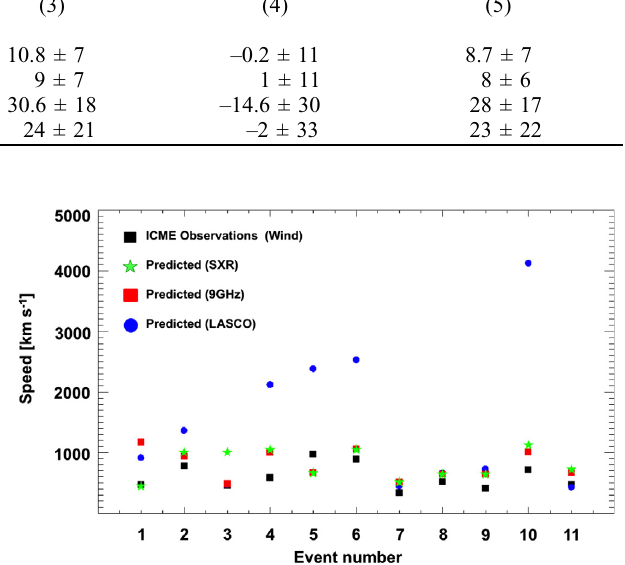
Fig. 8. Comparison between the observed and predicted ICME speeds at 1 AU. The black squares represent the speeds measured by Wind. The red filled squares show the predicted speeds from 9 GHz fluence. The green stars mark the predicted speeds from SXR fluence, while the blue circles represent the predicted speeds using coronographic observations. The abscissa shows the event number listed in Table